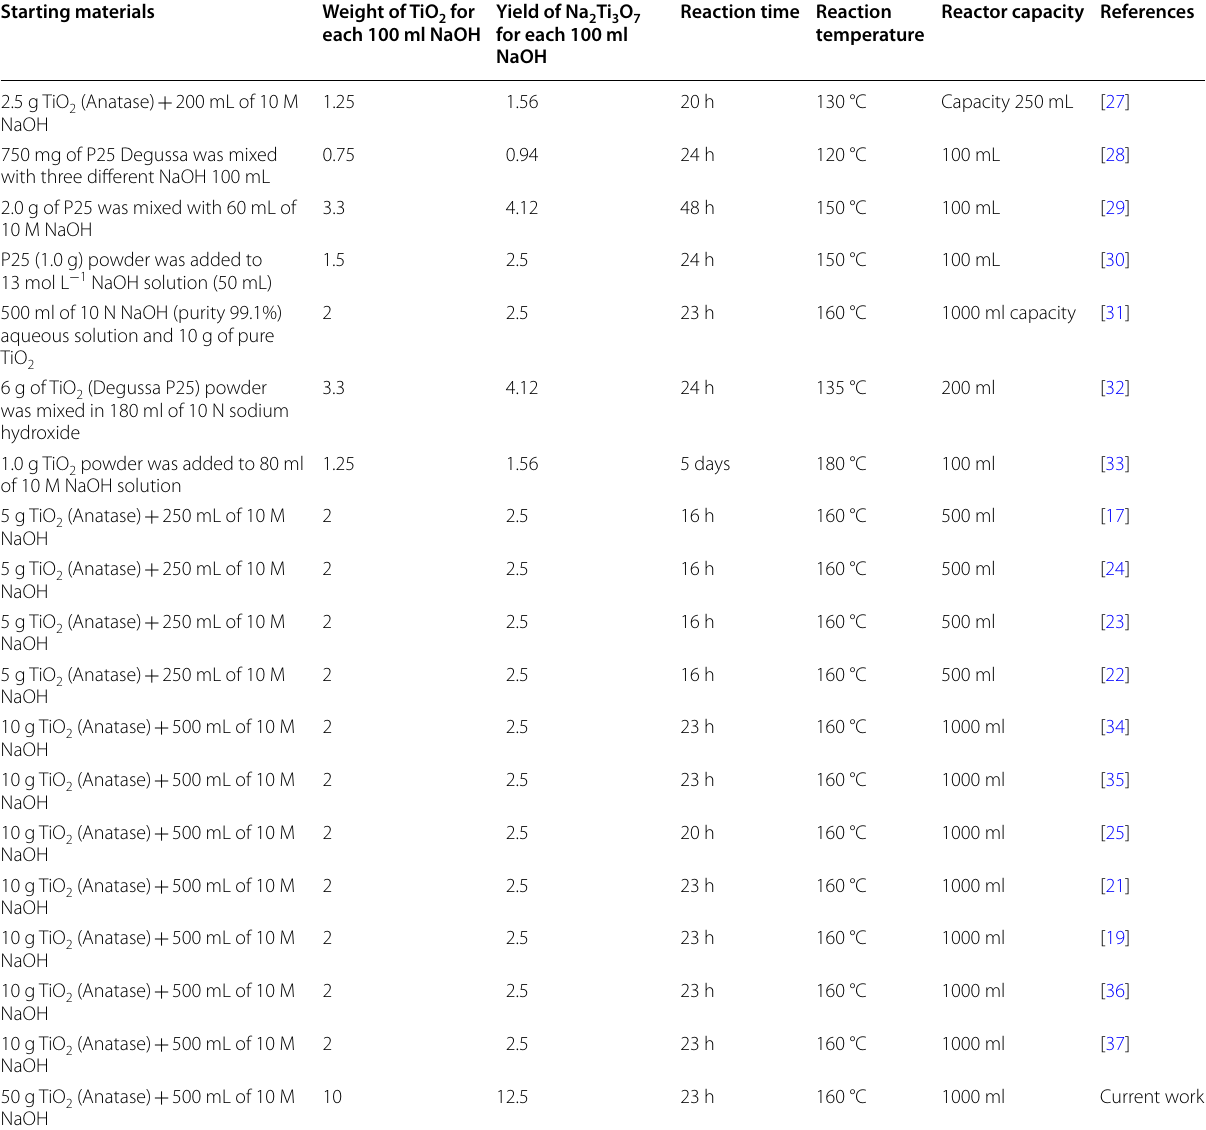
Table 1 Comparison between the yields of titanate with the other published work using the same preparation technique Starting